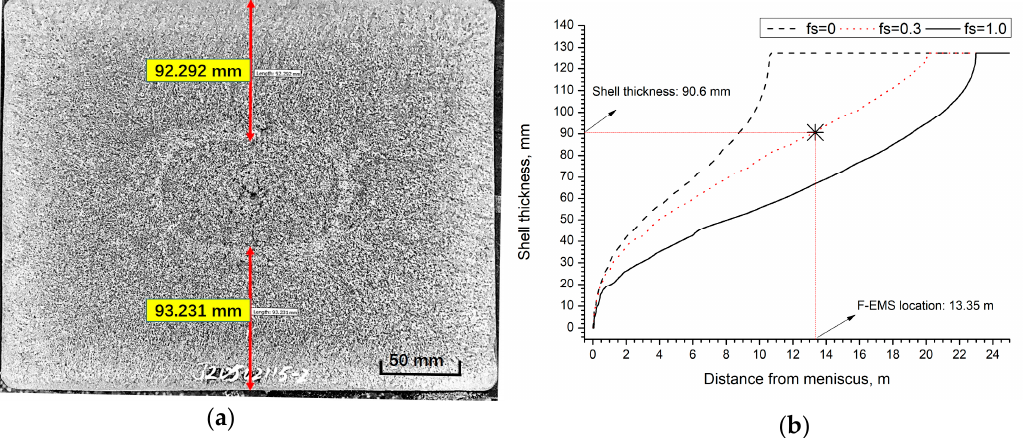
Figure 1. White band verification method result (steel 45): ( a ) Experimental and ( b ) simulated white band